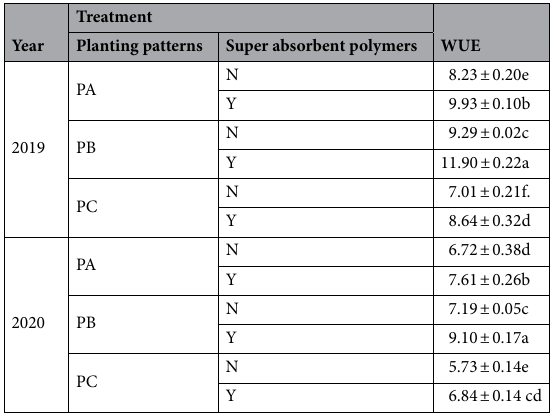
Table 7. Water use efficiency as affected by planting patterns and super absorbent polymers in 2019–2020. Different letters of different treatments in the same year showed significant differences (P < 0.05), and the following numbers showed the standard deviation of the